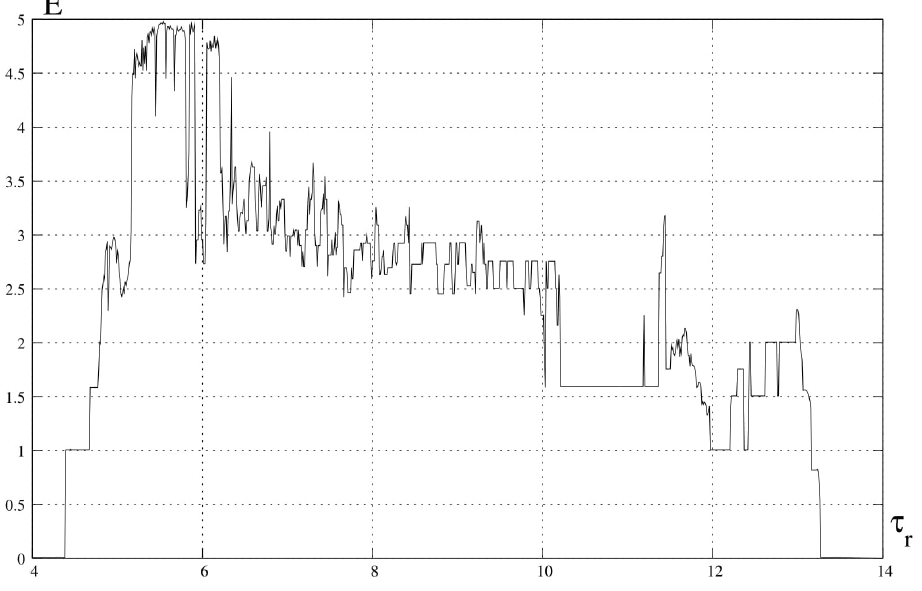
Figure 9. Diagram of information entropy for Da =